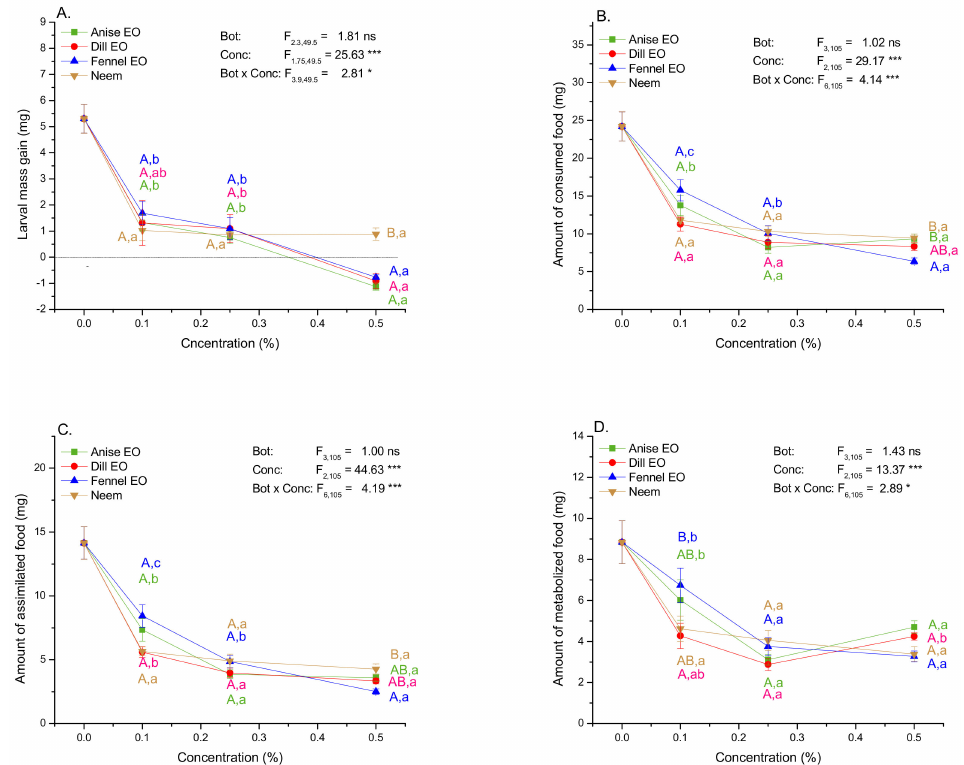
Figure 3. Mass gain ( A ) and amounts of consumed ( B ), assimilated ( C ) and metabolized food ( D ) (mean ± SE) in the 4th instar GML depending on the botanical type (Bot) (anise, dill and fennel EOs, commercial neem-based insecticide) and concentration (Conc). F − values indicate significance of the effects of Bot, Conc and interaction terms in two-way ANOVA ( * p < 0.05, *** p < 0.001). Significant differences among specific experimental groups are presented by different capital colored letters A, B (EO and neem comparisons within each concentration) and small letters a, b (comparisons among concentrations within each EO and neem) (LSM contrasts, p <